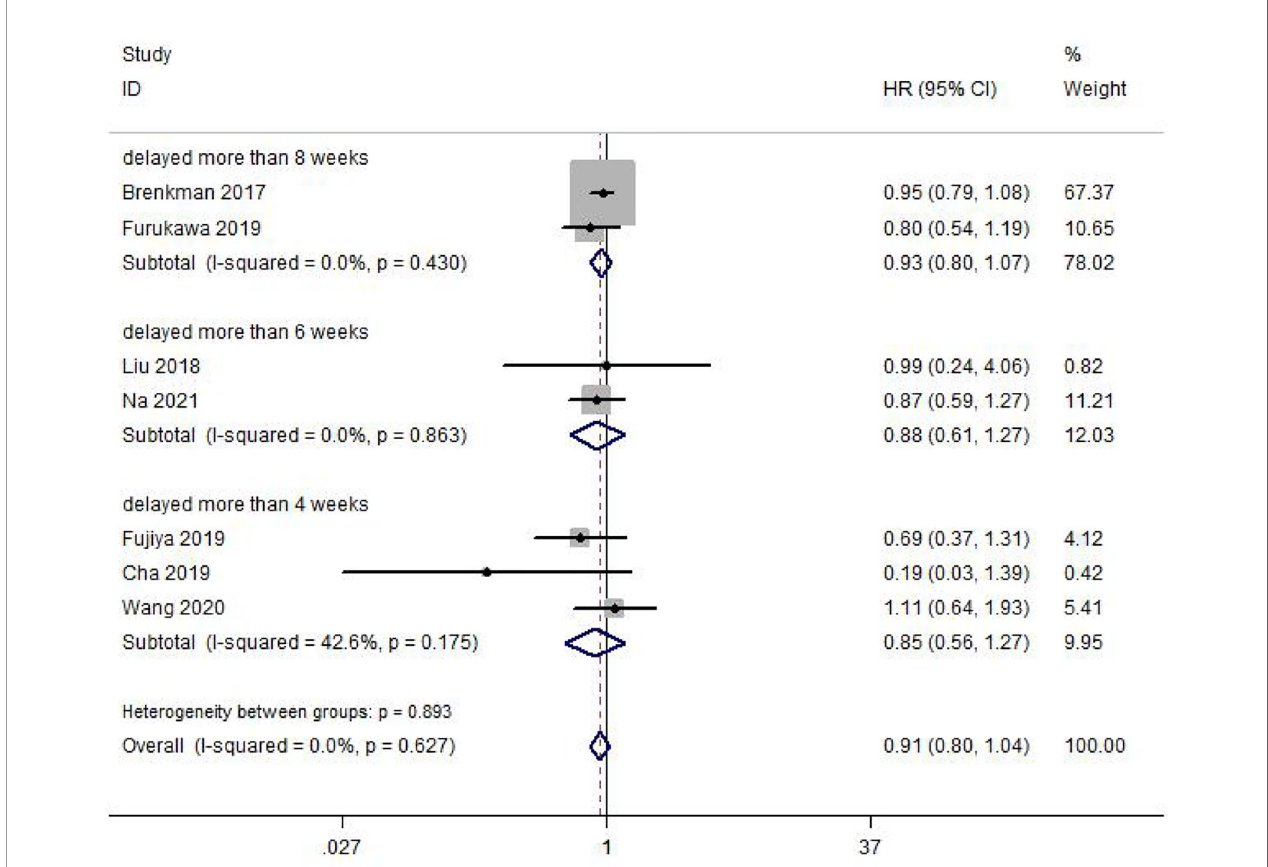
FIGURE 2 | Meta-analysis of the estimated hazard ratio for overall survival for a delay in gastric cancer surgery.